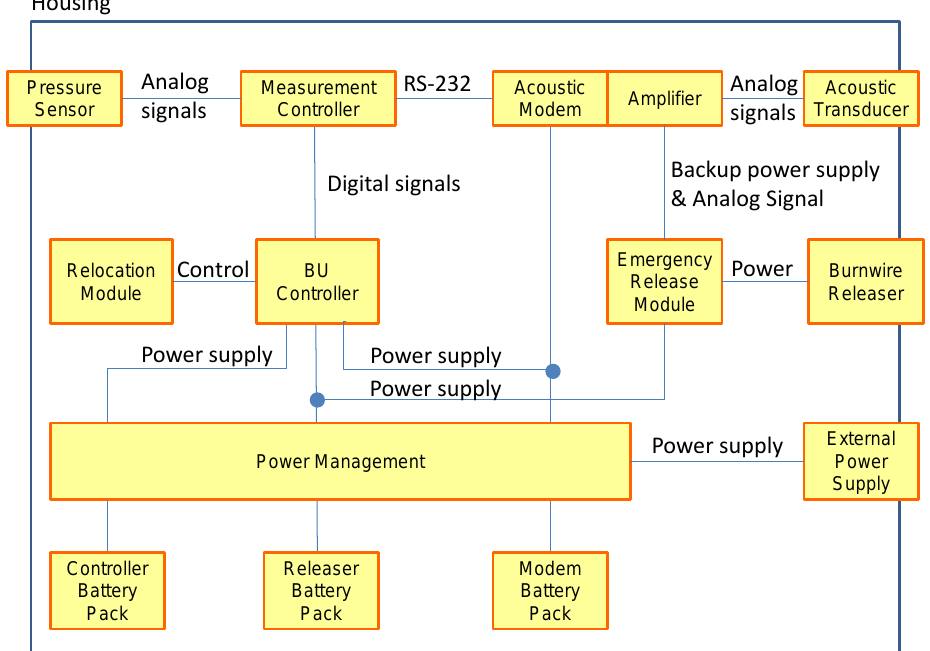
Fig. 11. Schematic diagram of functional groups of the PACT-BU.